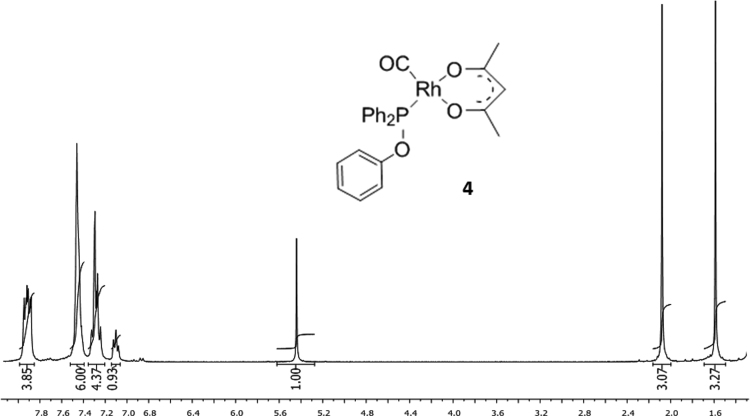
1H NMR of [Rh(acac)CO(C6H4OPPh2)],4.